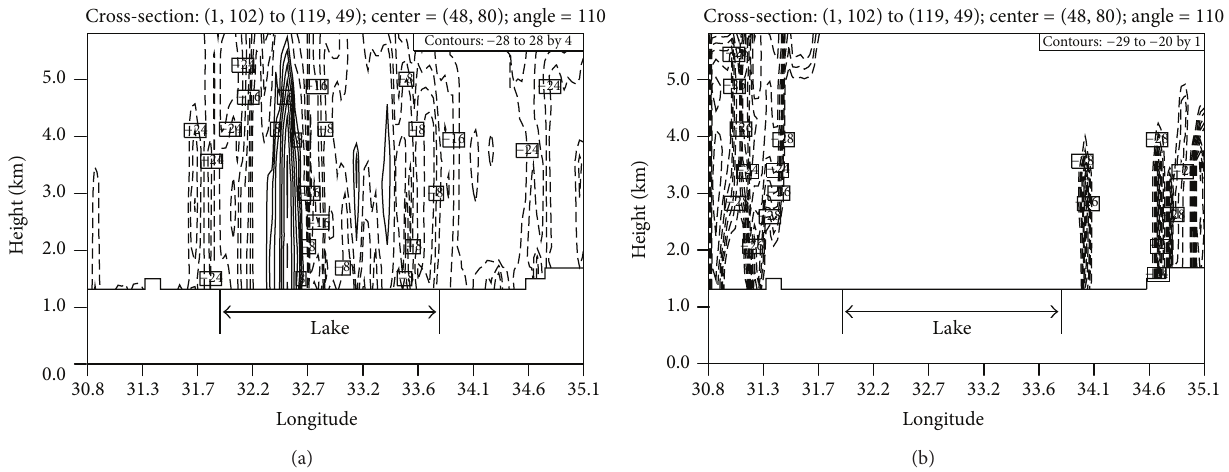
Figure 14: Cross-sections of radar reflectivity (in dBZ) along the two-rainfall maxima at (a) 0600 LST and (b) 1500